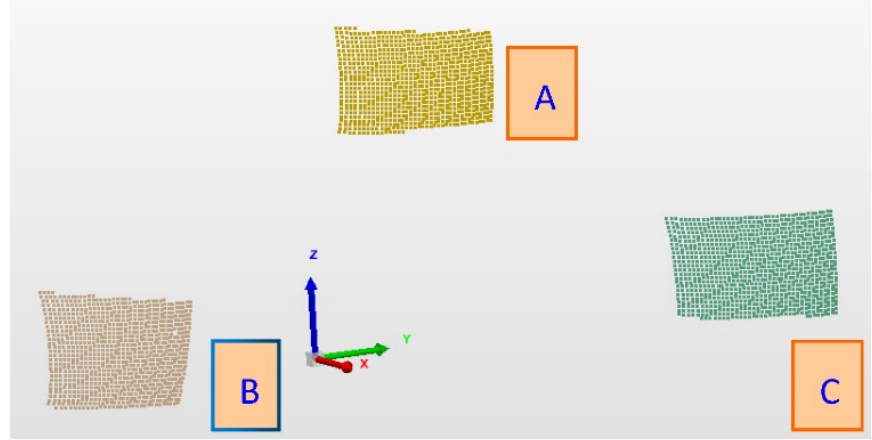
Figure 7. Point clouds obtained from laser scanning of the three balls.